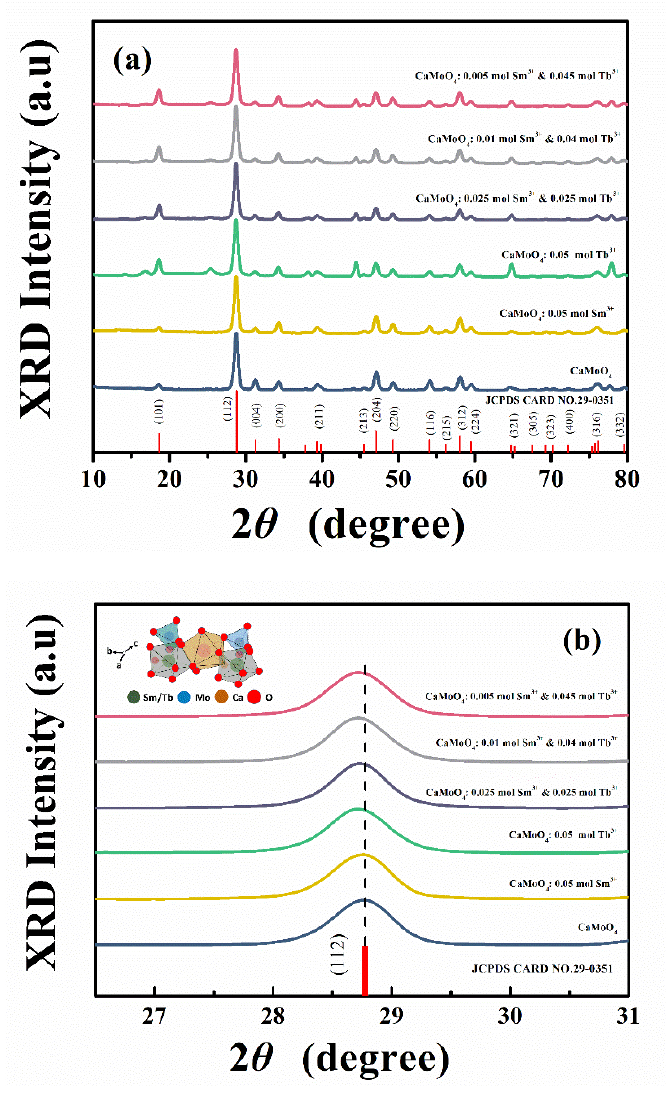
Figure 1. ( a ) The XRD patterns and ( b ) enlarged view of (112) peak of undoped-CaMoO 4 and Sm 3+ /Tb 3+ co-doped CaMoO 4 with different molar ratios of Sm 3+ /Tb 3+ ions. The 12 and 300 K PL spectra of the undoped-CaMoO 4 phosphors measured